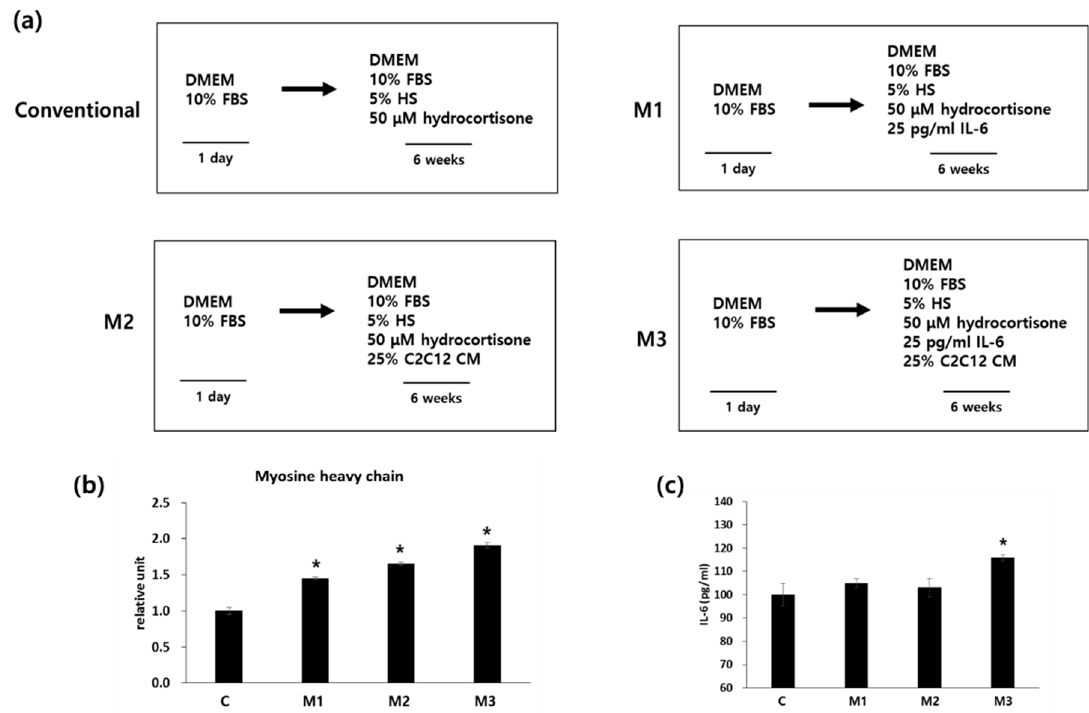
Figure 1. hADSCs were seeded and myogenic differentiation was induced for 6 weeks. ( a ) Schematic diagram of the differentiation protocols used. Protocol C is the conventional or common protocol.